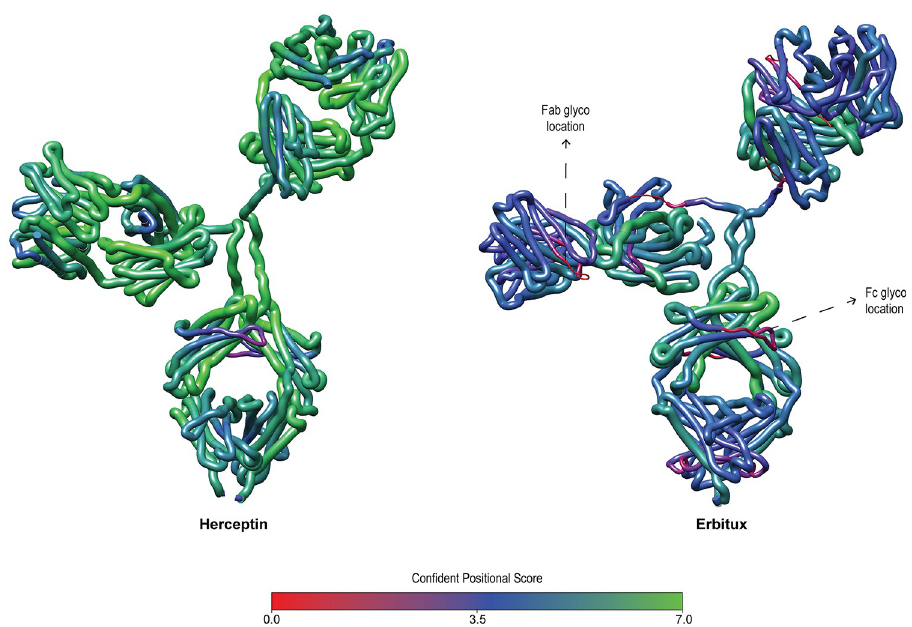
Fig 8. 3D segmented worm representation of the mAbs with the highest (Herceptin) and lowest (Erbitux) de novo MS sequencing CS values. The thickness and color of the protein chains are proportional to their CS